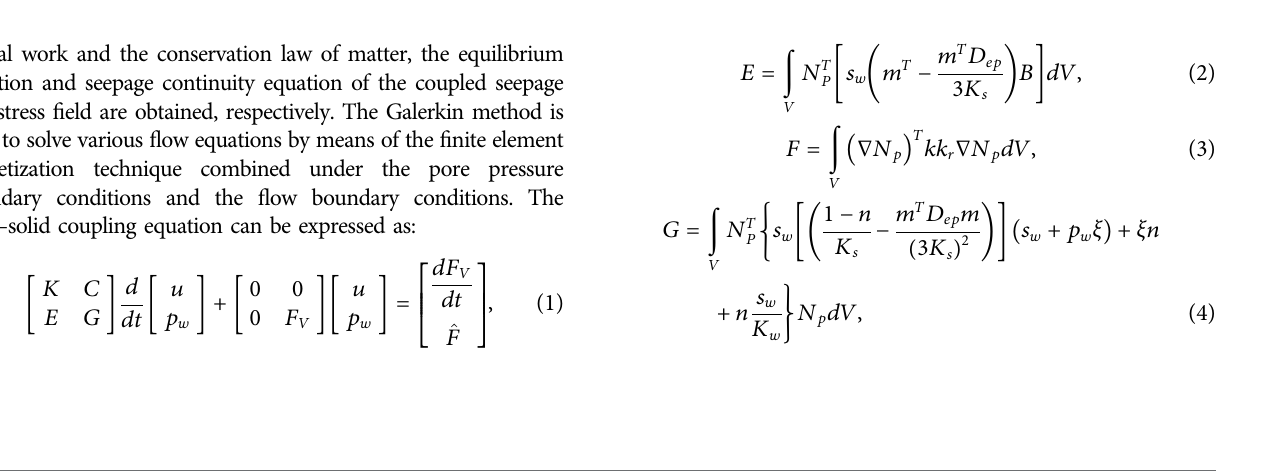
Frontiers in Earth Science |